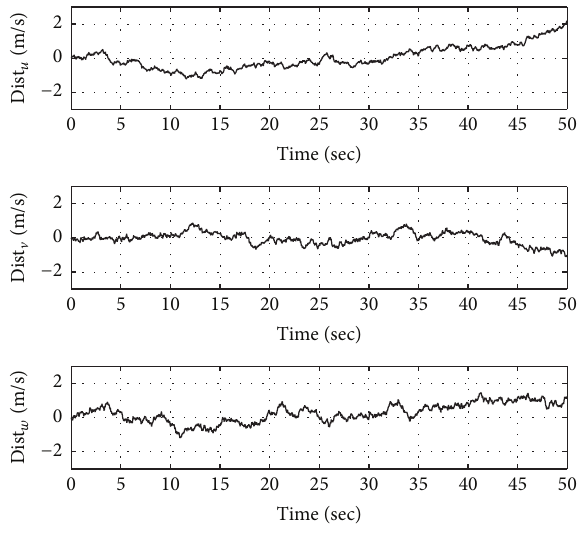
Figure 15: Disturbance model (Case 2).